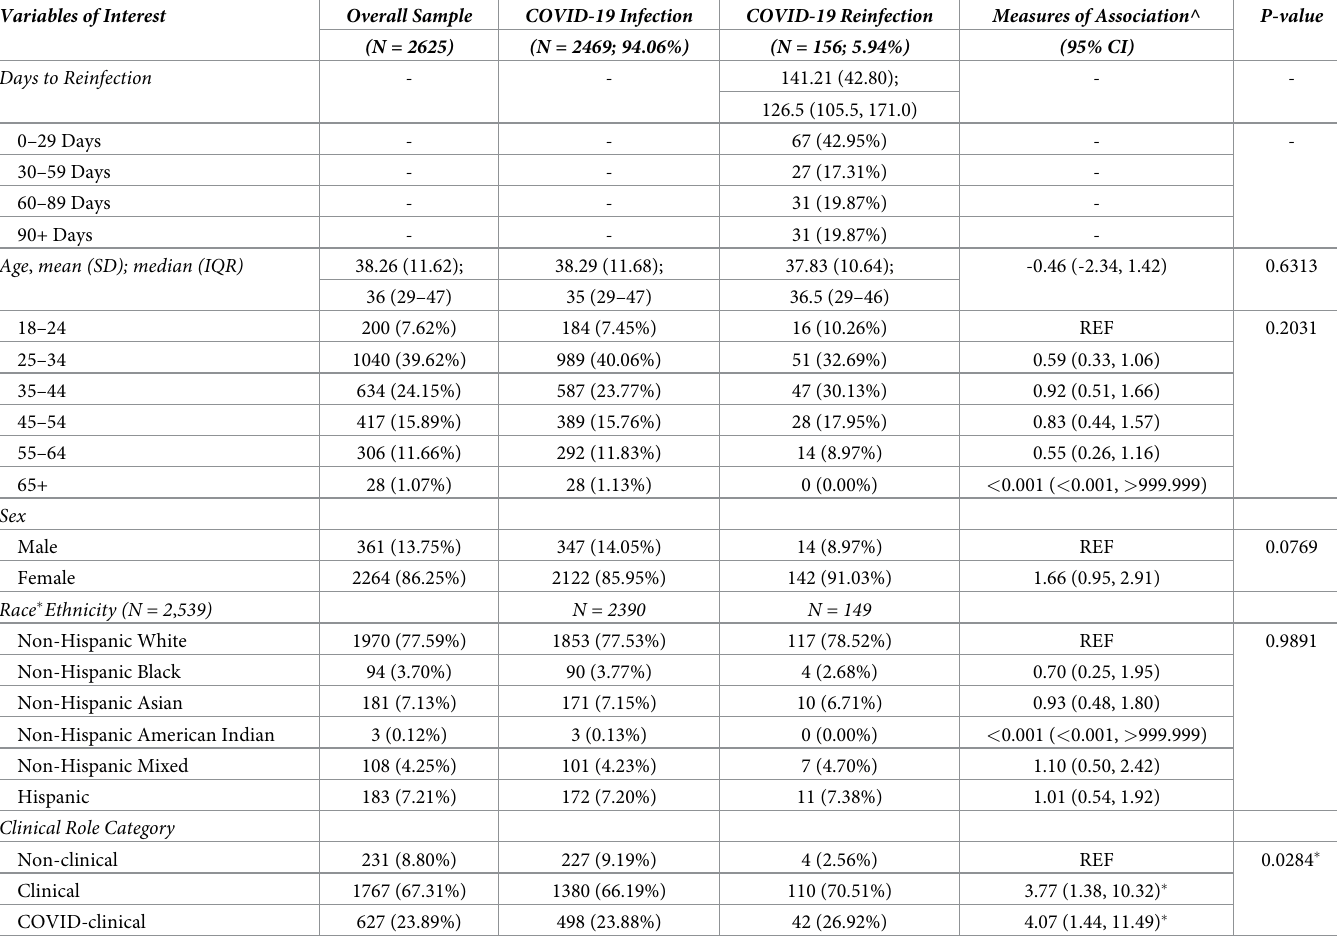
Table 2. Demographics of Sample of Healthcare Employees, Overall and by COVID-19 Reinfection Status.